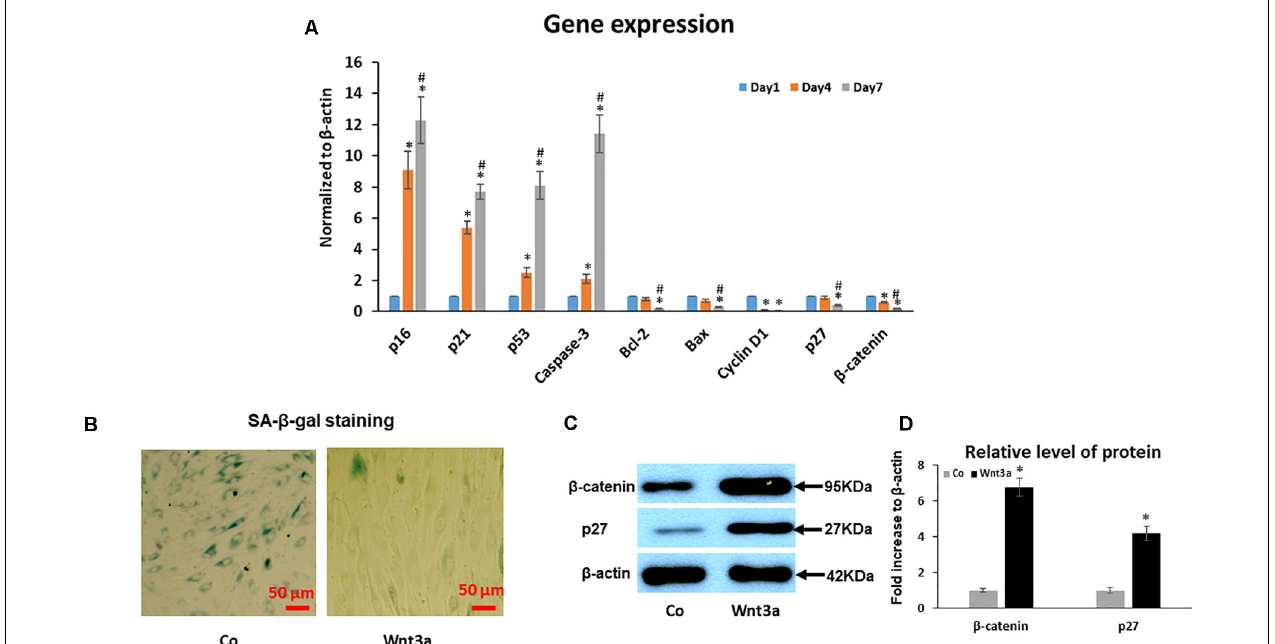
FIGURE 4 | Effect of cell sheet culture on senescence and apoptosis related gene expression. (A) Expression of cell aging related genes was tested by Real-time PCR using total RNA isolated from BMSC sheets, including p16, p21, p53, p27 and Caspase-3. Anti-aging gene expression of Bcl-2, Bax, Cyclin D1, and β -catenin. * P < 0.05 vs. Day 1 cells and # P < 0.05 vs. Day 4 cells. All experiments were performed in triplicate. (B) SA- β -gal staining showed that 3-day Wnt3a treatment reduced cell senescence in cell sheet cultures. (C) Western blot showed an increase of p27 and β -catenin in BMSCs after treatment with Wnt3a for 3 days. (D) Quantification of western blot bands shown in (C)